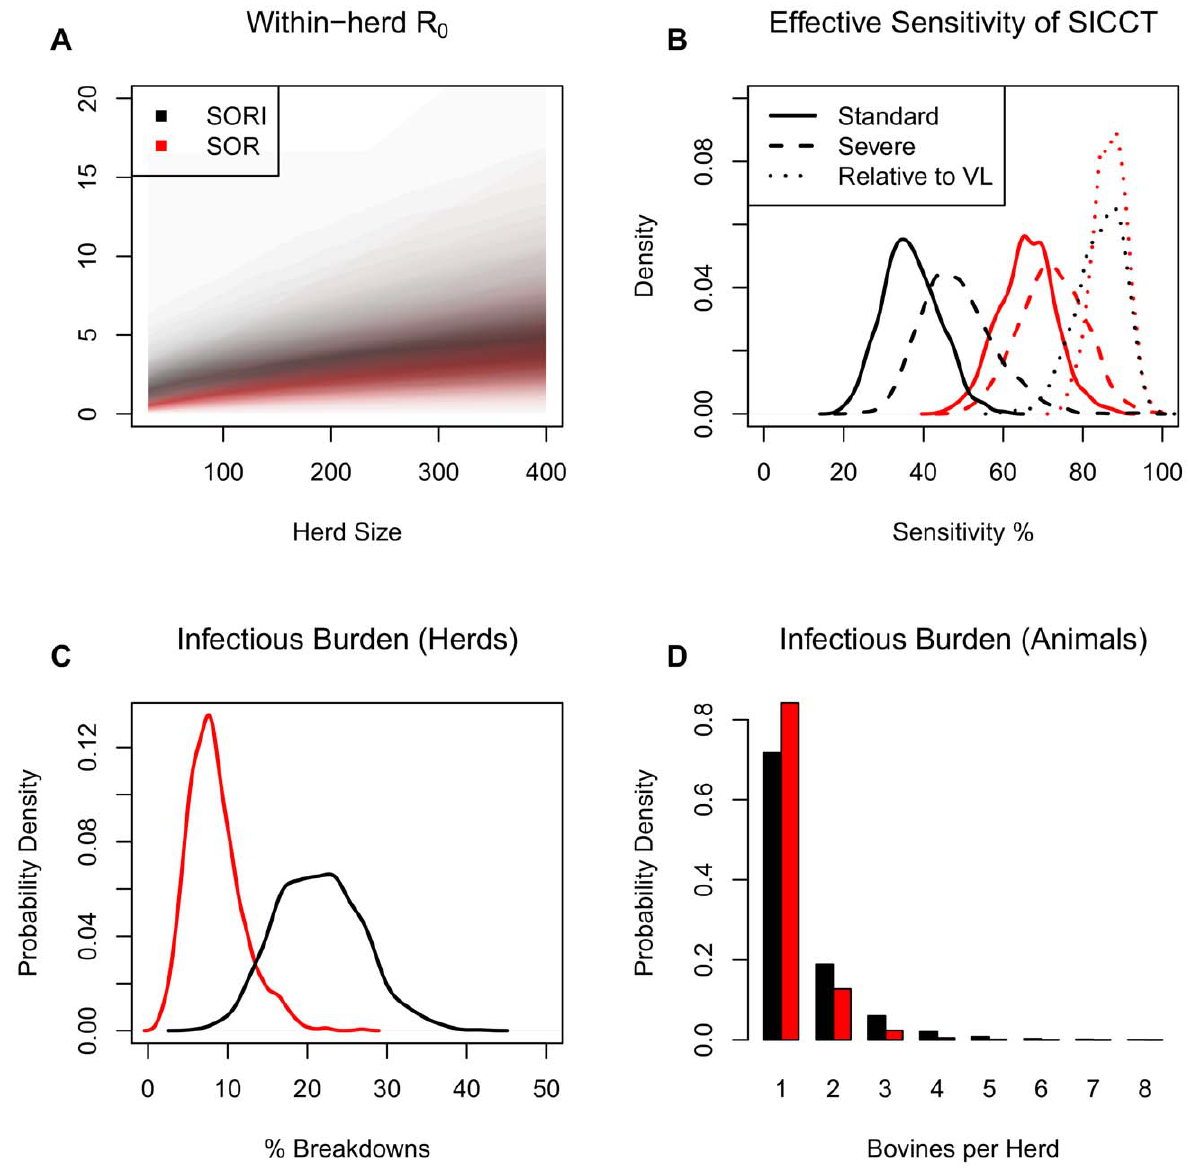
Figure 3. Herd level measures of efficiency of transmission and clearance of infection for SORI and SOR models. ( A ) Predictive distribution for the within-herd reproduction ratio (R 0 ), plotted as a shaded density strip where the intensity of shading is proportional to the b probability that R 0 takes a given value [35]. We calculate R 0 ~ ( H = H m ) 1 { q where q measures the strength of density dependence, b is the m estimated transmission parameter and m the per capita rate of turnover of the herd sampled from an empirical distribution and H m ~ 165 . Both models estimate that transmission is non-linearly density dependent with point estimates for the invasion threshold (R 0 =1) of 71 (8–674,95% CI) for the SORI model and 12 (1–833, 95% CI) for the SOR model. ( B ) The effective sensitivity of the SICCT test within our study population of herds measured under the standard (solid line) and severe (dashed line) interpretations and relative to the gold standard of confirmation with visible lesions (dotted line). ( C,D ) The infectious burden remaining after movement restrictions are lifted can be characterized in terms of the number of herds with at least one infectious animal remaining when movement restrictions are lifted ( C ) and the expected distribution of animals on those herds ( D ). Predictive distributions for ( B,C,D ) are calculated by simulating from the empirical distribution of herds taken from our study population, representing the national distribution of